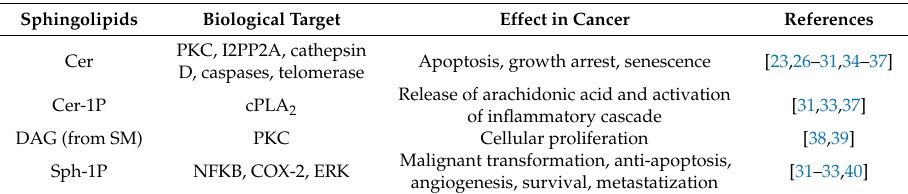
Table 2. Roles of sphingolipids in